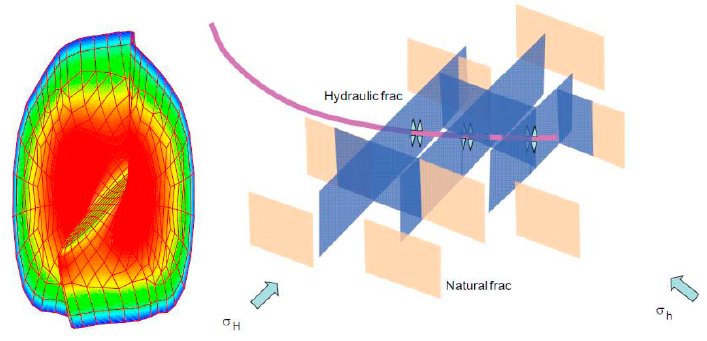
Figure 1. Nonplanar fracture model in a naturally fractured formation.